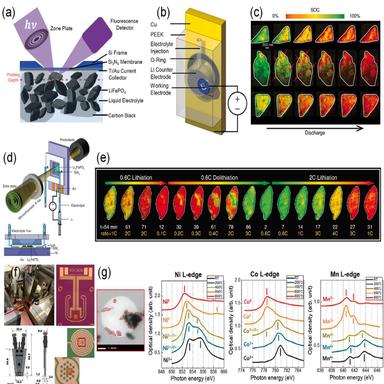
.2. In situ STXM of lithium-ion battery and battery materials. (a) Schematic of in situ XRF-STXM of a thick LiFePO4 working electrode enclosed in liquid electrolyte and the geometry of the X-ray beam and the XRF detector; (b) schematic of the electrochemical cell containing a LiFePO4 working electrode, a Li counter electrode, and organic liquid electrolyte in a PEEK housing; (c) state of charge (SOC) maps of three representative LiFePO4 platelet particles as the electrode discharges at a rate of 0.2 C image